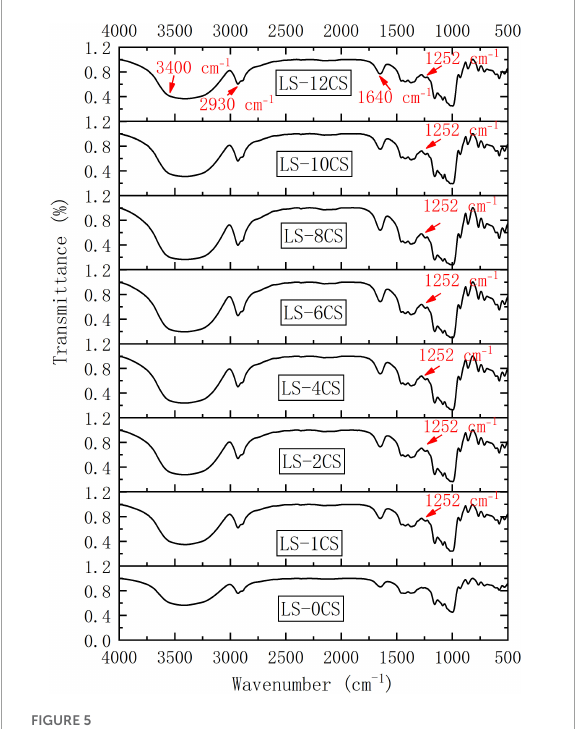
FIGURE5 FT-IR spectroscopy of lotus seed cross-linked resistant starch